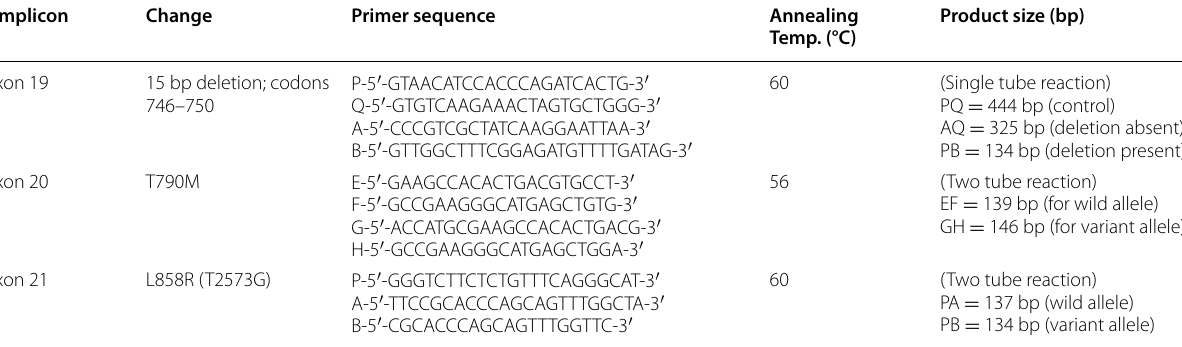
Table 1 Primers, product size and annealing temperatures used to detect mutations, if any, in various exons of EGFR gene by ARMS- PCR and